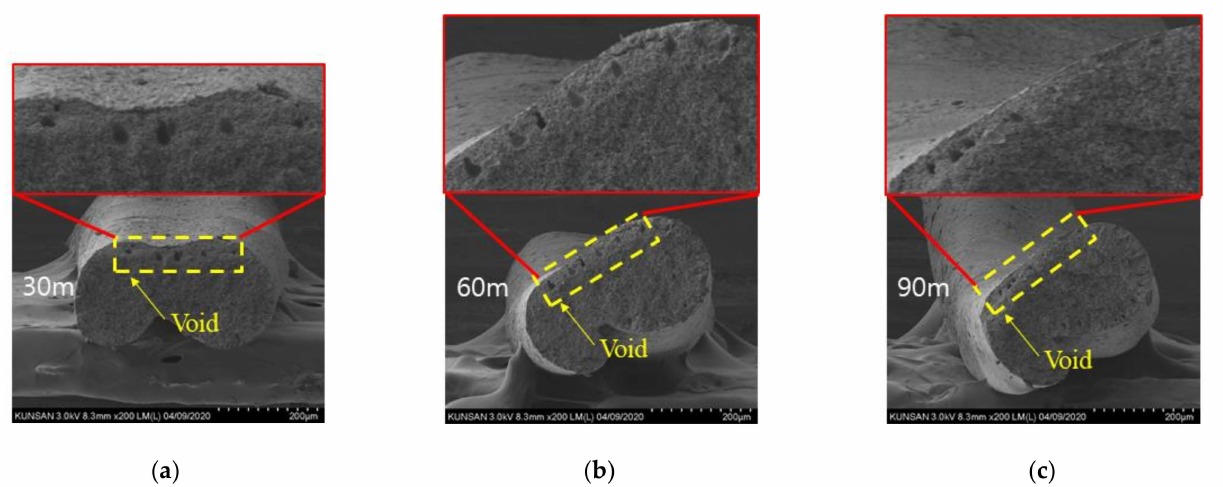
Figure 13. SEM images of case 2 ( x 1 : x 2 : x 3 : x 4 = 60:60:120:200). ( a ) Specimen 30 m; ( b ) Specimen 60 m; ( c ) Specimen 90